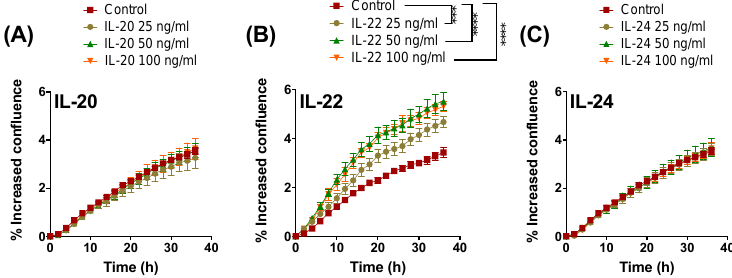
Figure 1. Effects of interleukin (IL)-20 subfamily of cytokines on intestinal LS174T cell proliferation. Cells were treated with 25, 50, or 100 ng/mL of ( A ) IL-20 ( B ) IL-22 or ( C ) IL-24. Cell proliferation was assessed in a live-cell imaging system for 36 h under serum free conditions. Data are presented as mean ± SEM of percentage of increased confluency in each time point of cell proliferation assay. ( n = 6, two independent experiments). *** p < 0.001; **** p < 0.0001 compared with control (two-way ANOVA followed by Bonferroni’s post-hoc